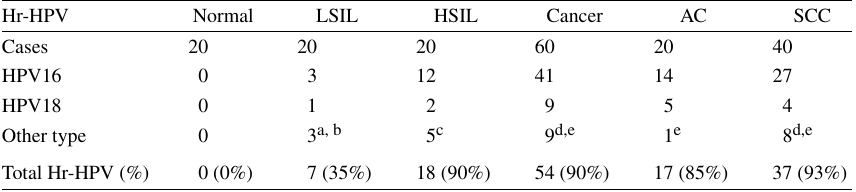
Hr-HPV analysis in paraffin samples